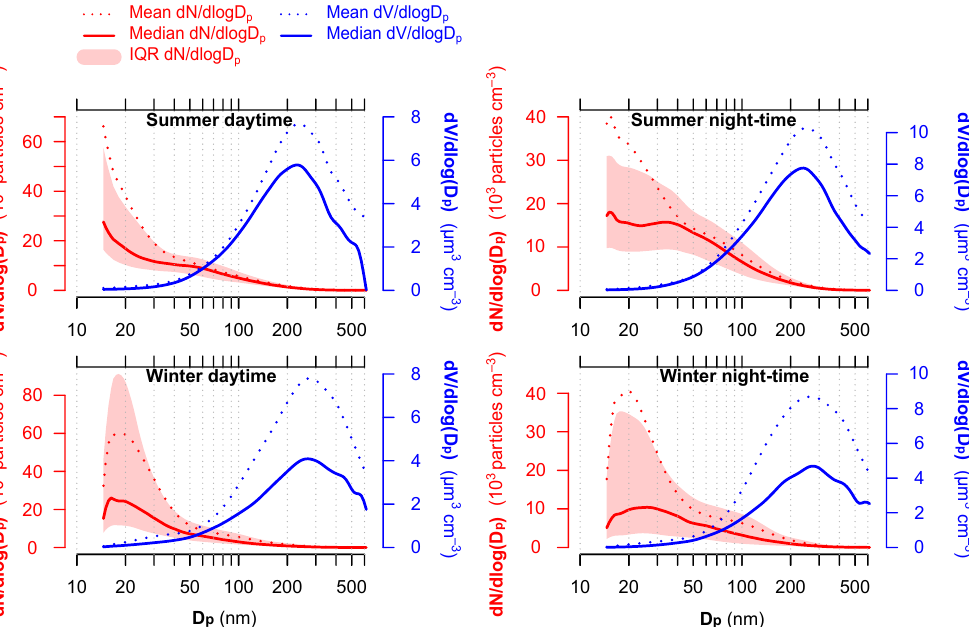
Figure 1. Statistics of size distribution spectra for particle number (red) and volume (blue) concentrations categorised by sampling periods and time of the day (daytime: 07:00–19:00; night-time: 19:00–07:00 local time). For the particle number spectra, solid lines represent the median concentrations, while shaded areas report the first to third quartile intervals (interquartile range, IQR). For the particle volume spectra, only medians are reported (dotted lines).